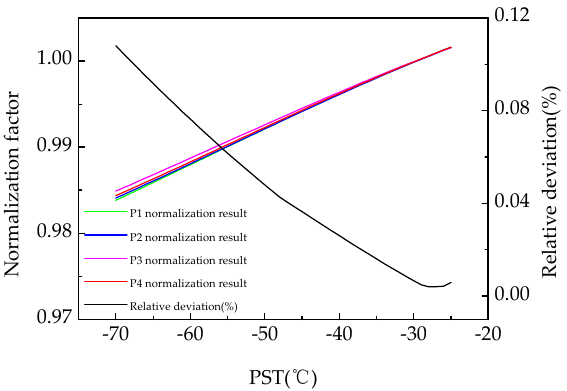
Figure 18. Comparison of the temperature characteristic consistency for 4 cells at 2250 nm . The experimental results indicated that their responsivity temperature dependences were generally consistent, and the maximum relative deviation was 0.11% in the temperature range of − 70 °C < T < − 25 °C .